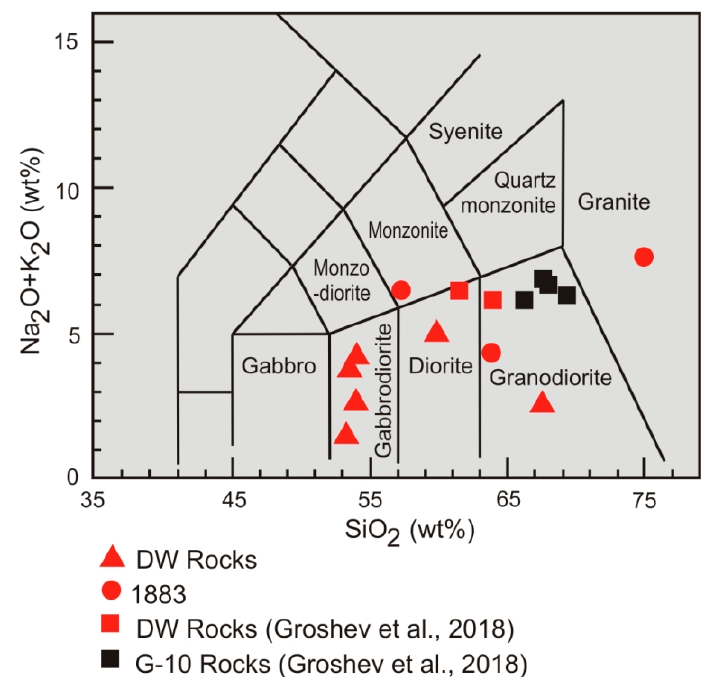
Figure 9. The rocks from the DW block, drill hole 1883, and the Gabbro-10 massif (G-10) in the TAS (total alkali-silica) diagram for plutonic rocks proposed by Middlemost [22].